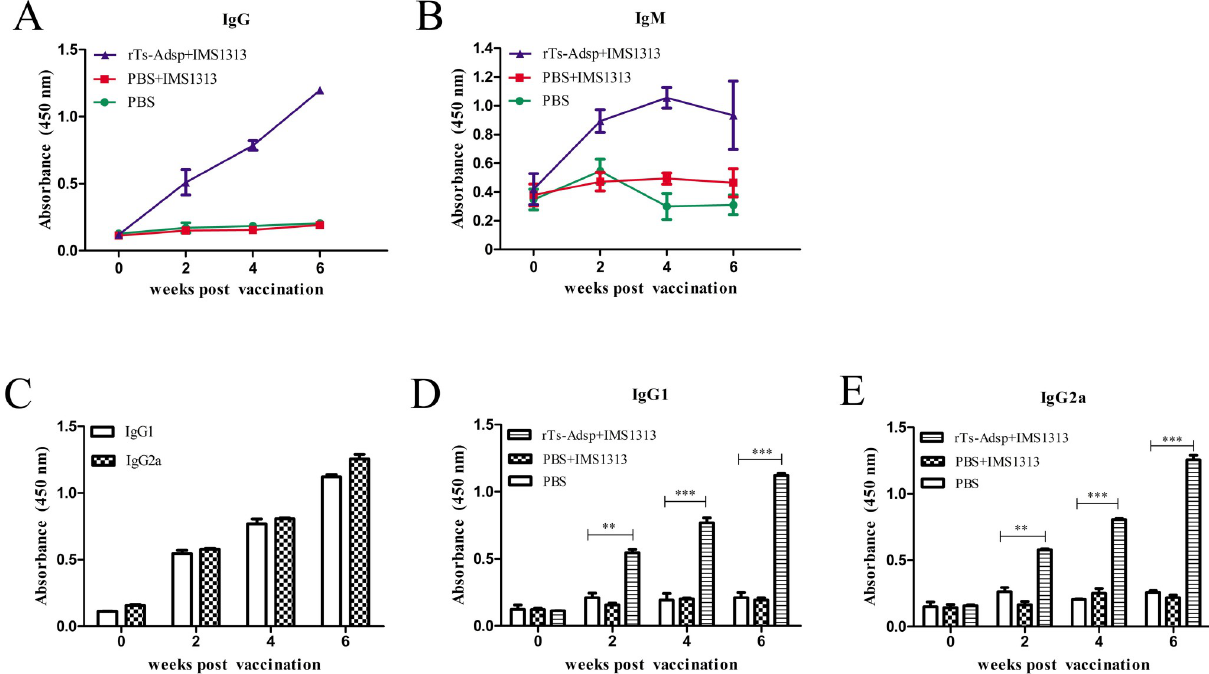
Fig 2. Immune responses from the vaccinated pigs. (A) The levels of IgG against rTs-Adsp were measured by ELISA. (B) The levels of IgM in the sera of immunized pigs were measured by ELISA. (C) IgG subclass responses to the rTs-Adsp were measured by ELISA. (D) The IgG1 subclass responses against rTs-Adsp were evaluated at different time points. (E) The IgG2a subclass responses against rTs-Adsp were evaluated at different time points. The values shown for each group are the mean ± SD of the antibody levels. Significant differences were as follows: � p < 0.05; �� p < 0.01; ��� p < 0.001.